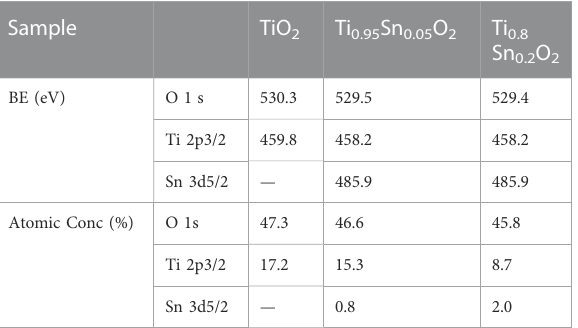
TABLE 3 States of Ti 0.95 Sn 0.05 O 2 and Ti 0.8 Sn 0.2 O 2 solid solution and elemental surface composition determined by XPS.